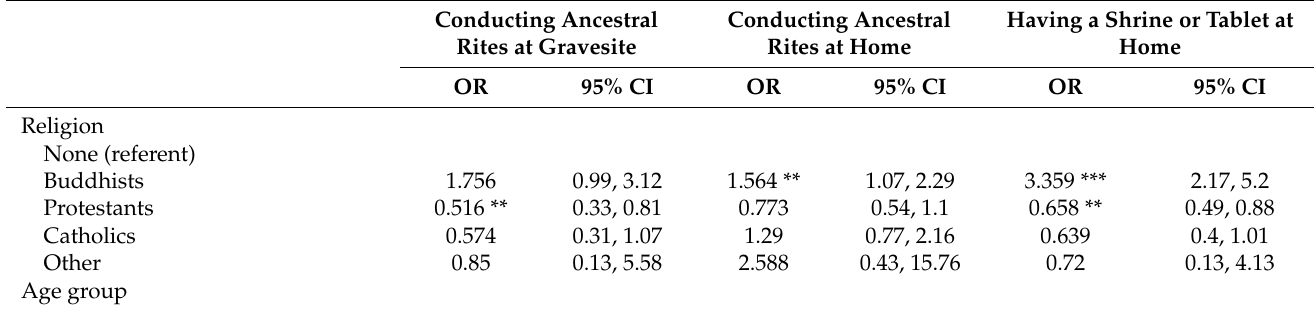
Table A2. Results of binary logistic regression on Confucian identification, beliefs, and practices